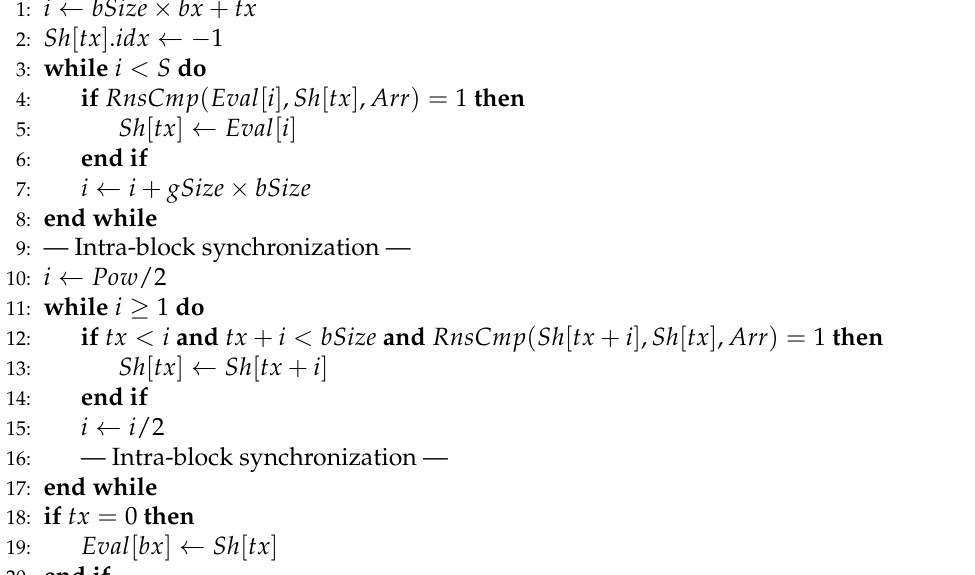
Algorithm 3 Reduction of an array of floating-point interval